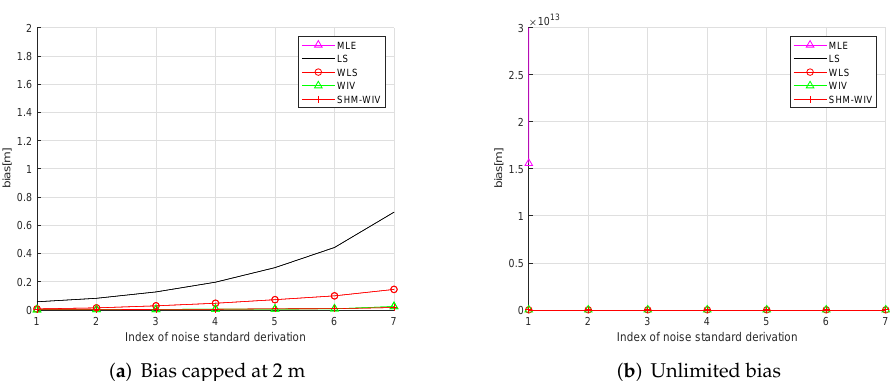
Figure 9. ( a ) Bias versus noise with randomized source location (bias is capped at 2 m); ( b ) Bias versus noise with randomized source location (MLE is missing in ( a ) as it diverges for entire noise